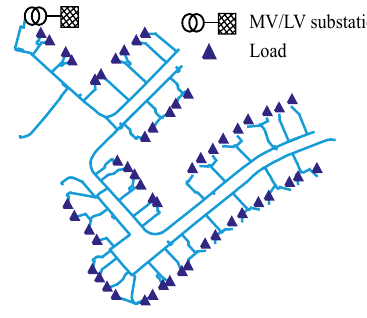
Figure 12. The IEEE European LV Test